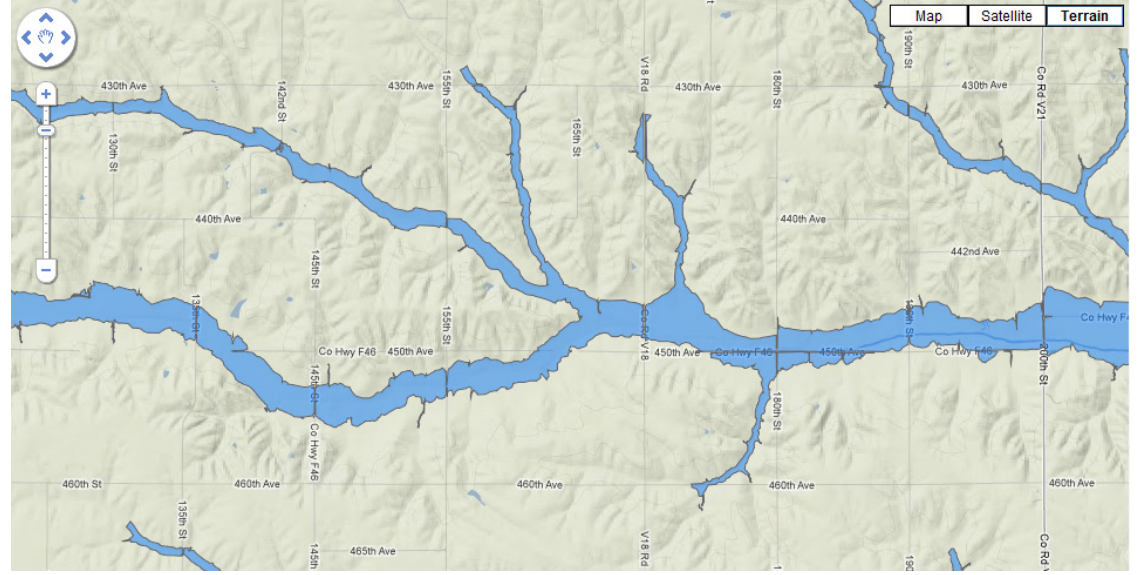
Figure 6. Preliminary floodplain mapping result for the 0.2-percent-annual-chance flood available on the Iowa Flood Center website [42]